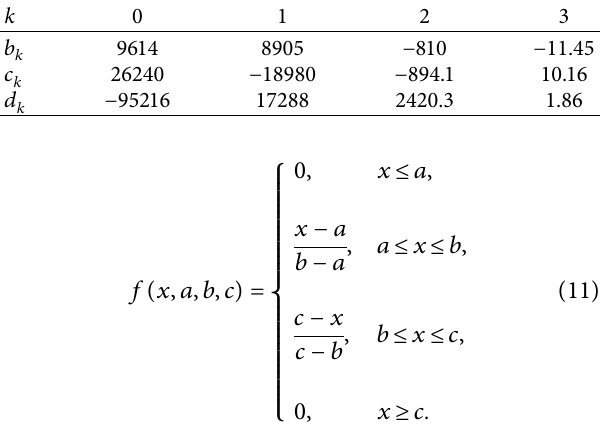
Table 1: Parameter identification